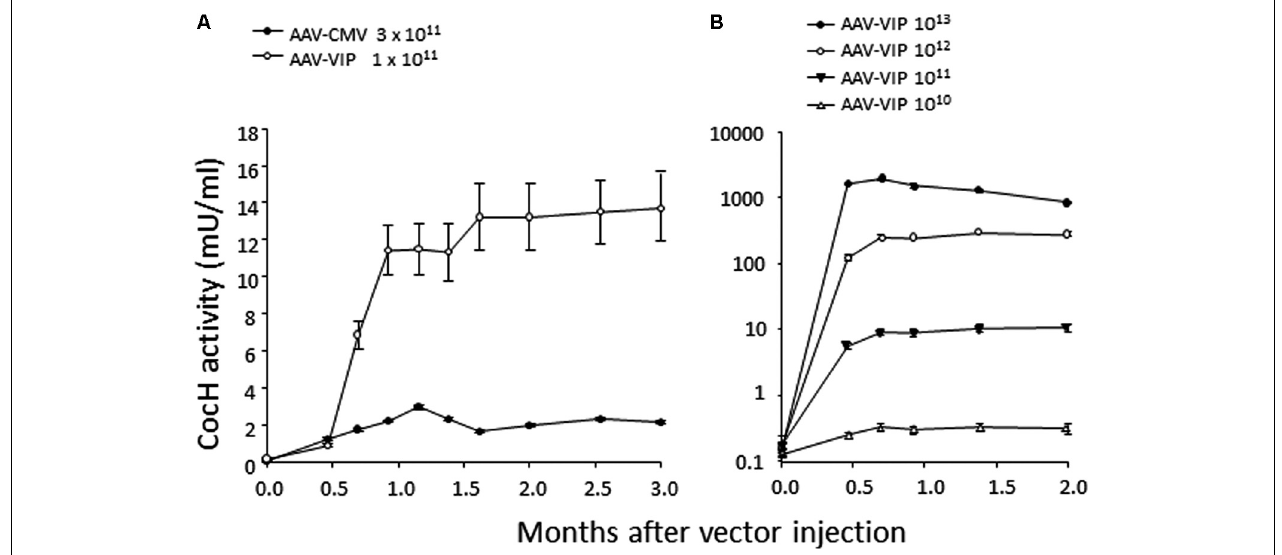
FIGURE 2 | Time course and dose-response measures of in vivo cocaine hydrolysis activity in mice given gene transfer of mutant mouse CocH with different viral vectors. (A) “Standard AAV vector” and (B) high doses of “AAV-VIP” vector. Note the log-linear 10-fold increments of hydrolysis matching the log-linear increments of vector (Geng et al., 2013, Figure 4).